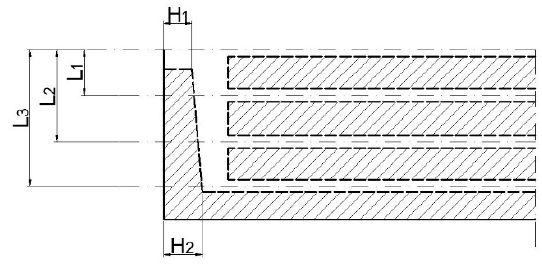
Figure 16. Flow chart of surrogate model-based optimization.